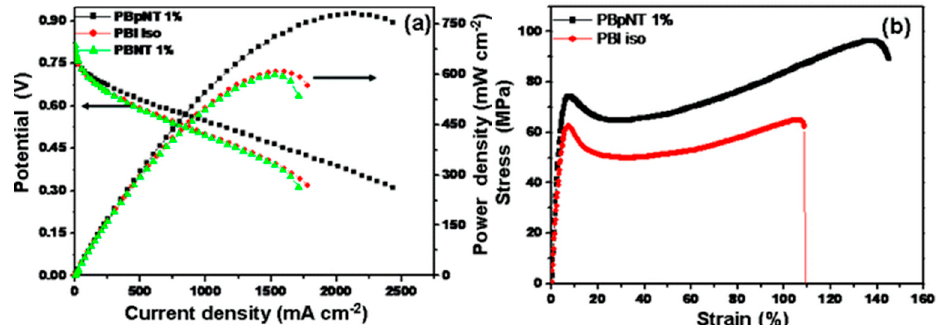
Figure 8. ( a ) Polarization plots of PBI iso, PBpNT, and PBNT composite membranes measured at 140 °C by passing dry H 2 and O 2 at a flow rate of 0.2 slpm. The cells were conditioned at 0.6 V for 30 min. ( b ) Stress − strain curve for the pristine PBI and PBpNT composite membrane; reproduced with permission from